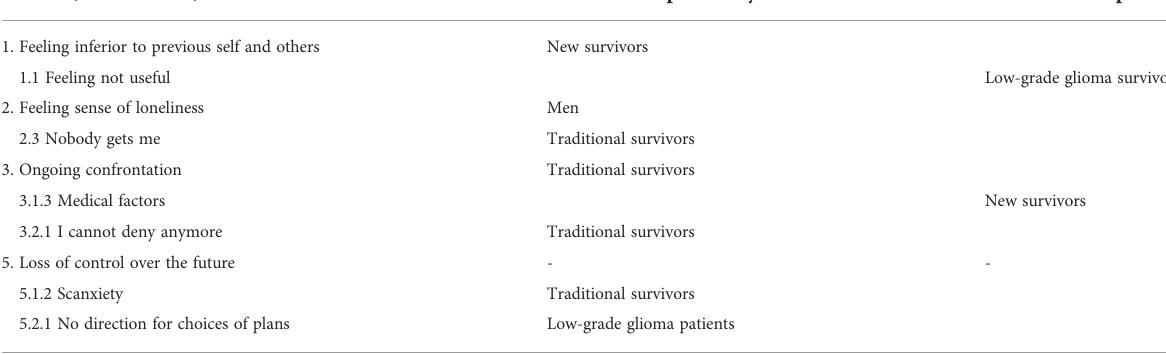
TABLE 4 Differences in experienced challenges between AYA